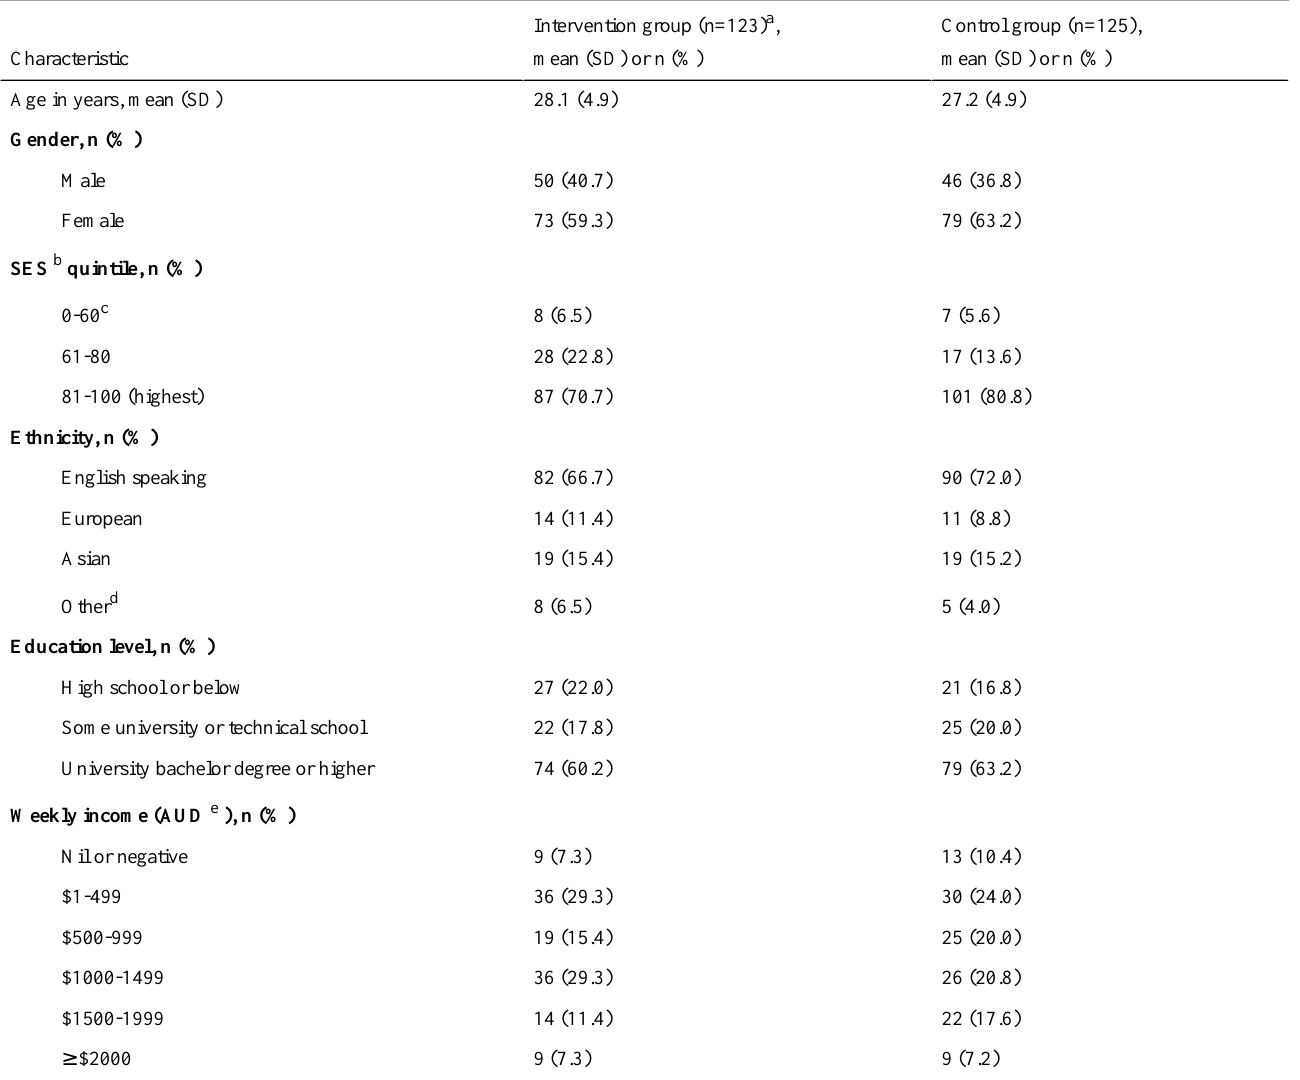
Table 1. Baseline demographic characteristics for all randomized participants in the TXT2BFiT study by allocation (n=248) a .